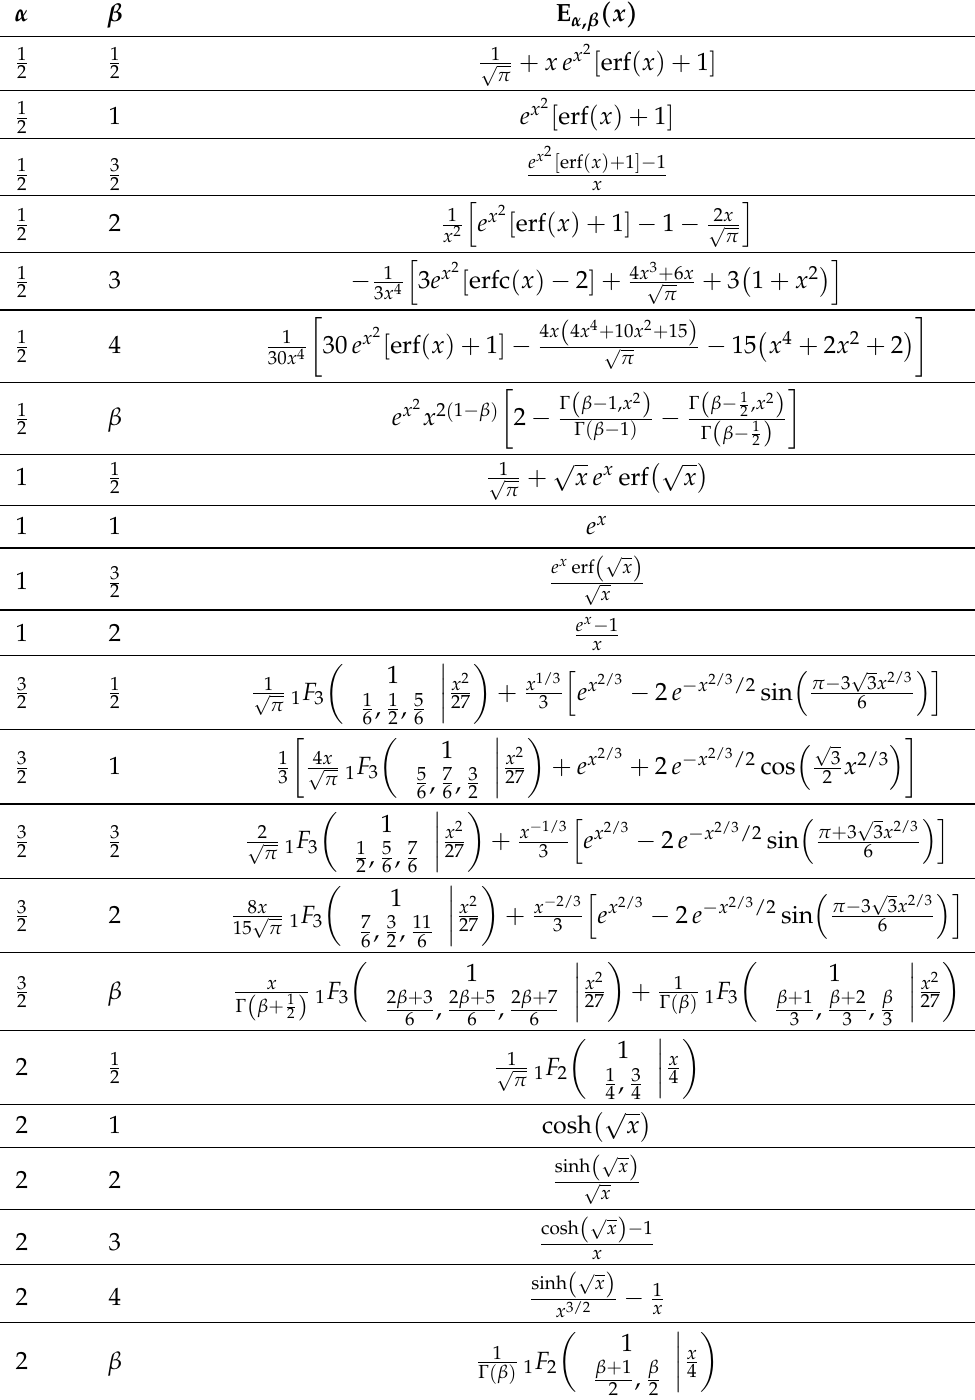
Table A1. The Mittag-Leffler functions derived for some values of parameters α and β by using